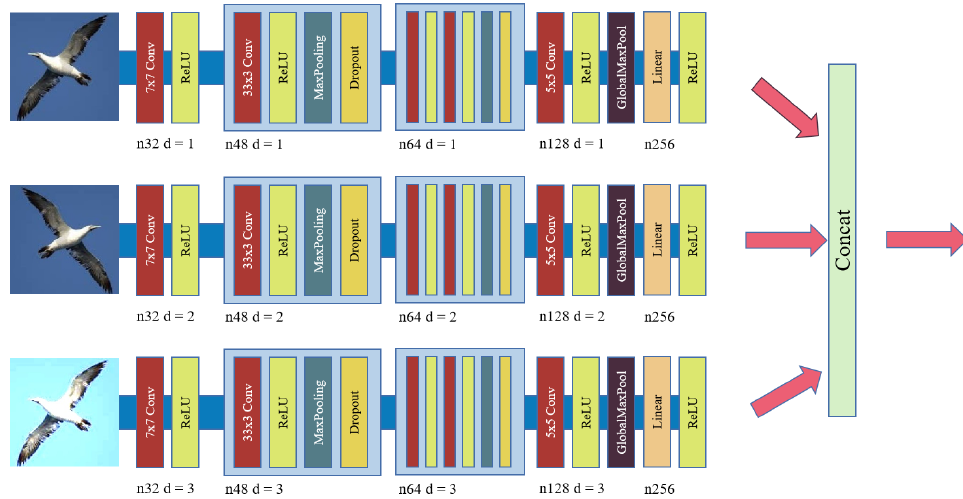
Figure 3. Diagram of Submodules.